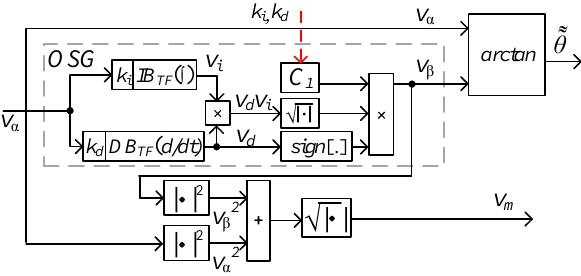
Figure 4. Derivative-Integral frequency independent OSG [26].